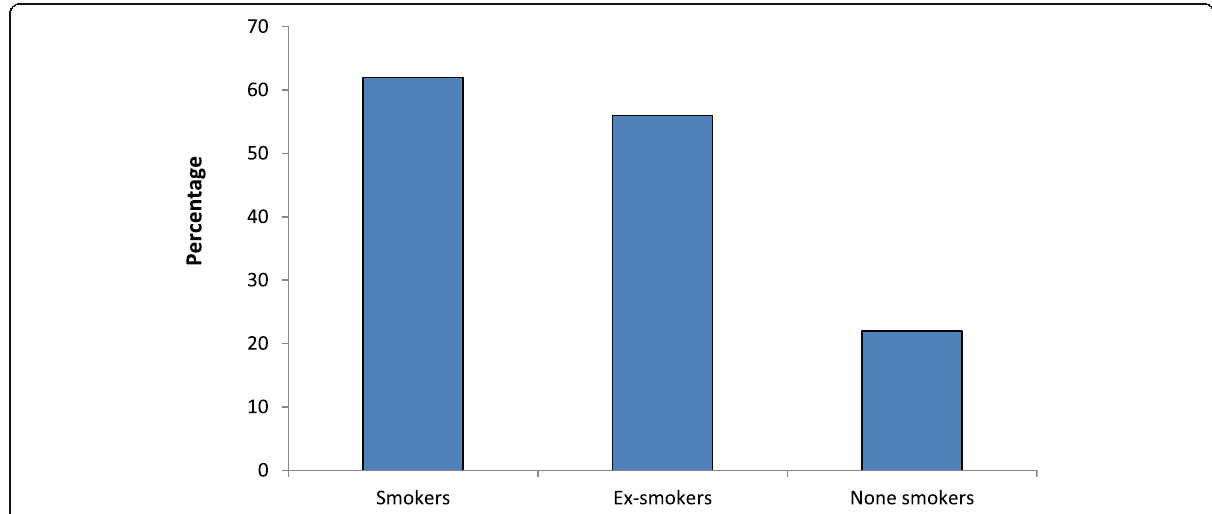
Fig. 3 Frequency of inhaled corticosteroid therapy among studied groups based on smoking